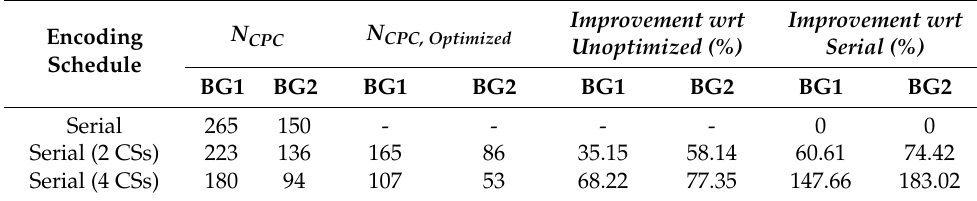
Table 2. Results of the GA